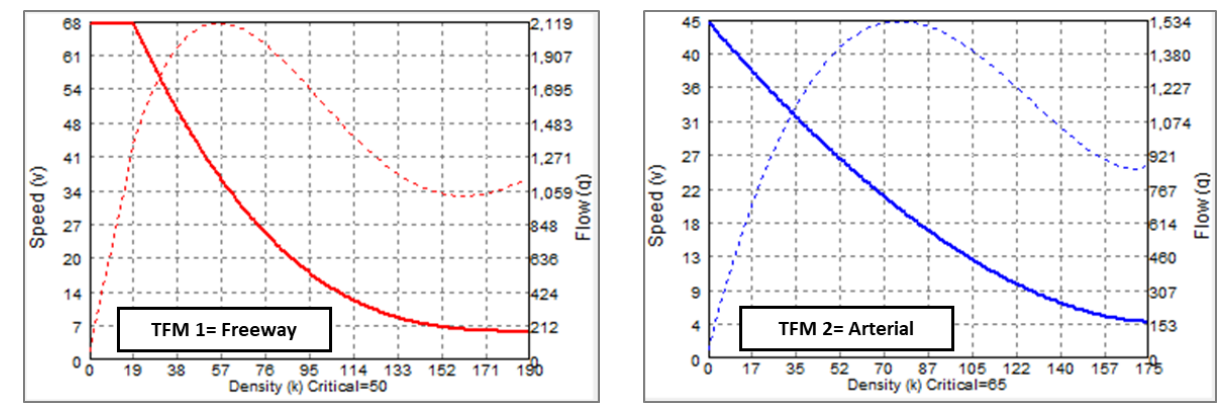
Figure 4: Traffic flow model profiles—freeway and arterial